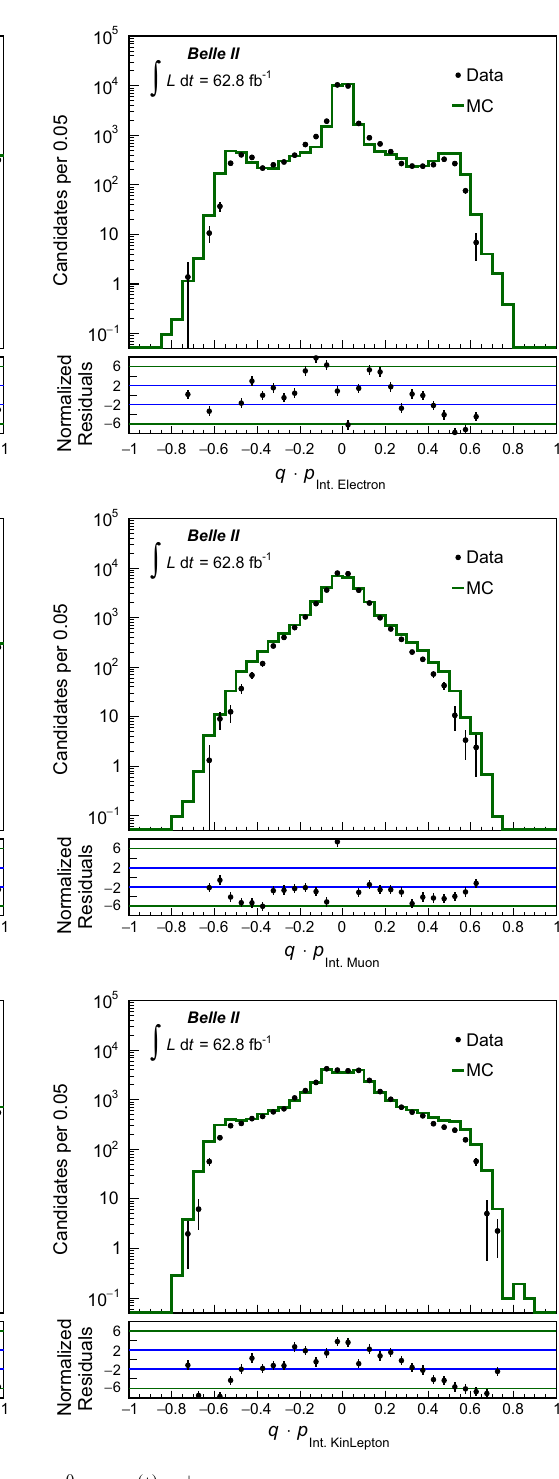
Fig. 9 Normalized output distributions of the Electron, Intermedi- ate Electron, Muon, Intermediate Muon, Kinetic Lepton, and Inter- mediate Kinetic Lepton categories in data and MC simulation for